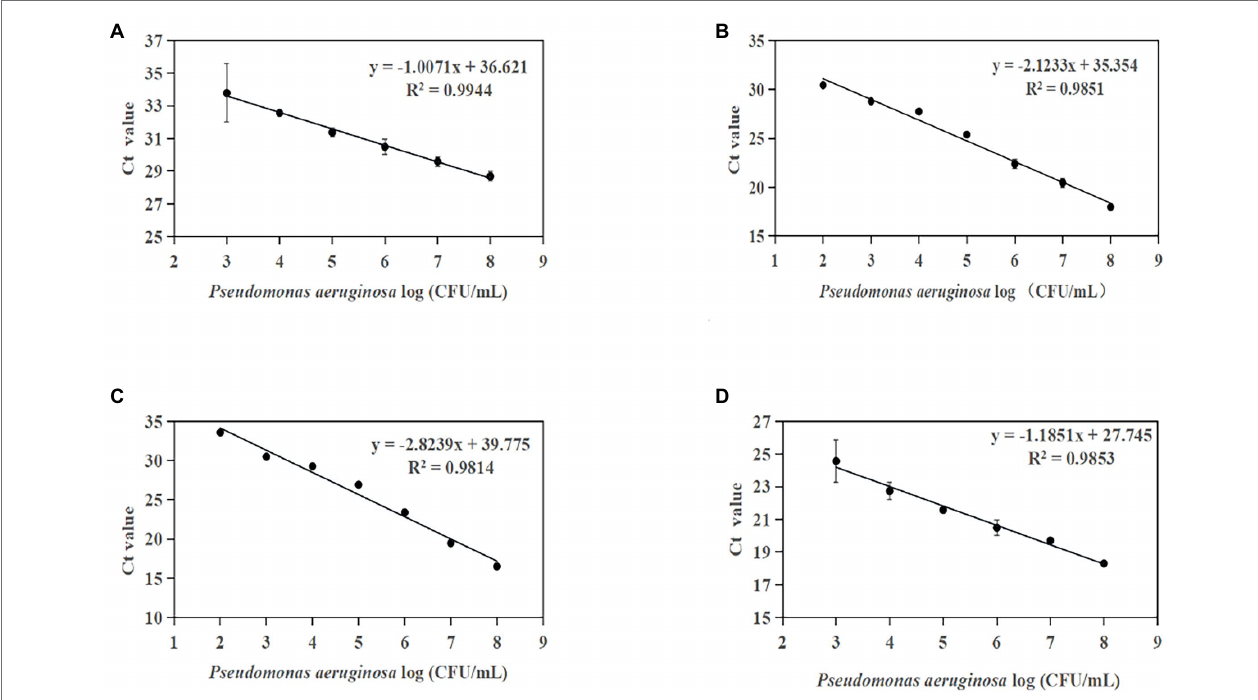
FIGURE 6 | Standard curves established by plotting cycle threshold (Ct) values against the log numbers of P. aeruginosa in pure culture from artificially contaminated tomatoes. (A) Primer set PA12 in a range of 10 4 –10 8 CFU/ml; (B) primer set PA13 in a range of 10 3 –10 8 CFU/ml; (C) primer set PA14 in a range of 10 3 –10 8 CFU/ml; and (D) primer set PA15 in a range of 10 4 –10 8